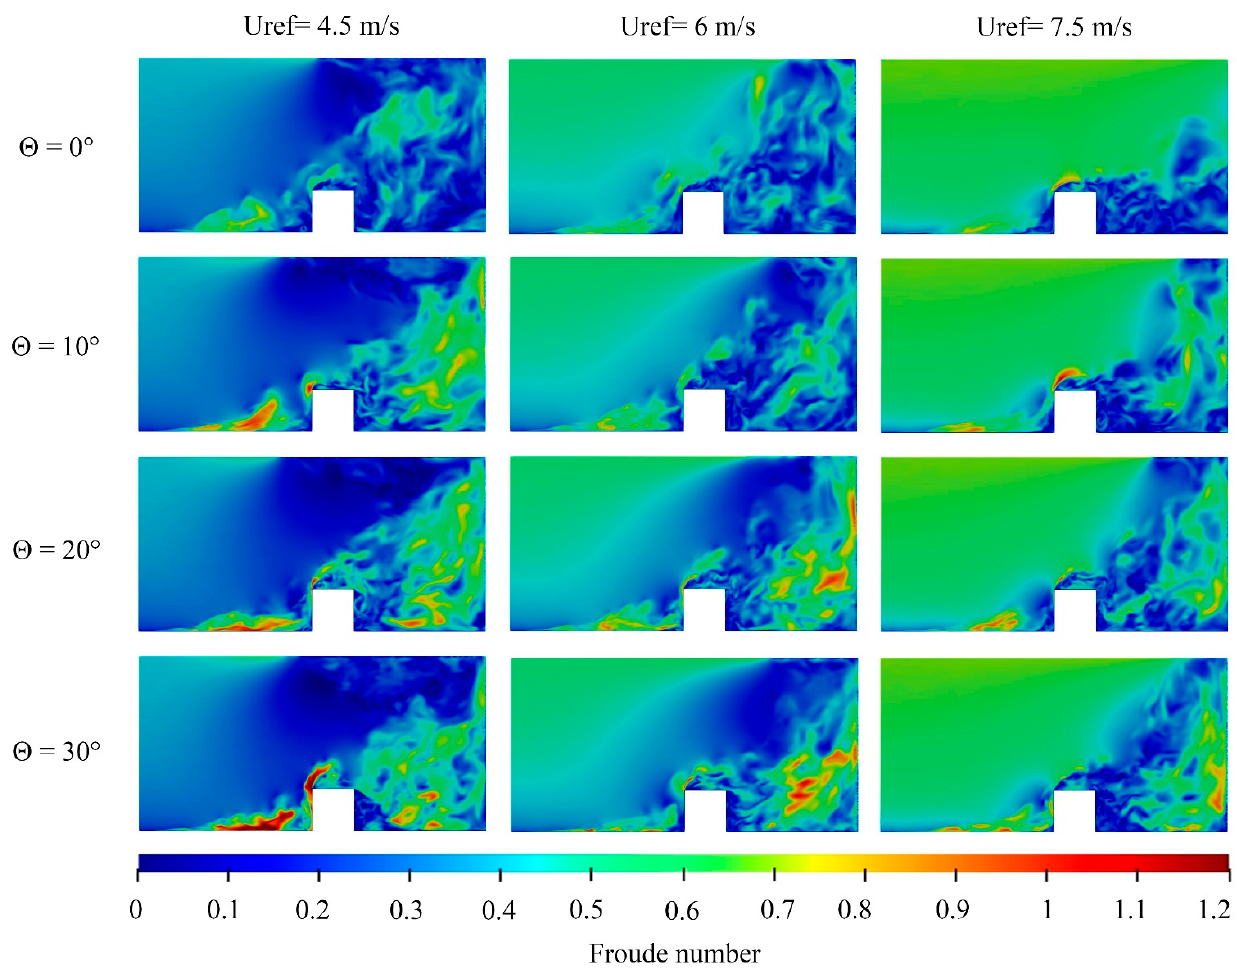
Figure 8. The contour of Froude number distribution on the domain in U ref = 4.5, 6, and 7.5 m/s and terrain slope 0°, 10°, 20°, and 30°.